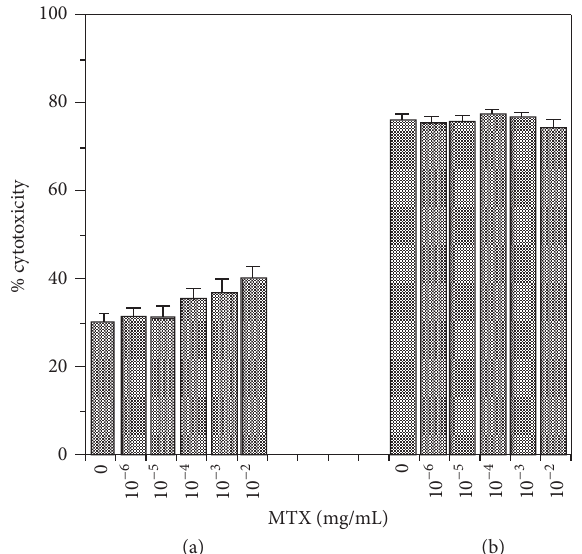
Figure 6: Effect of MTX on cytotoxicity of TNF- 𝛼 secreted by LPS-pulsed AMC. After 1h of 0.02 𝜇 g/mL LPS stimulation, AMC were washed and further incubated for 2 h (a) or overnight (b) in the presence of MTX at various concentration (10 −6 to 10 −2 mg/mL). TNF cytotoxicity in 10x diluted supernatants was analyzed.